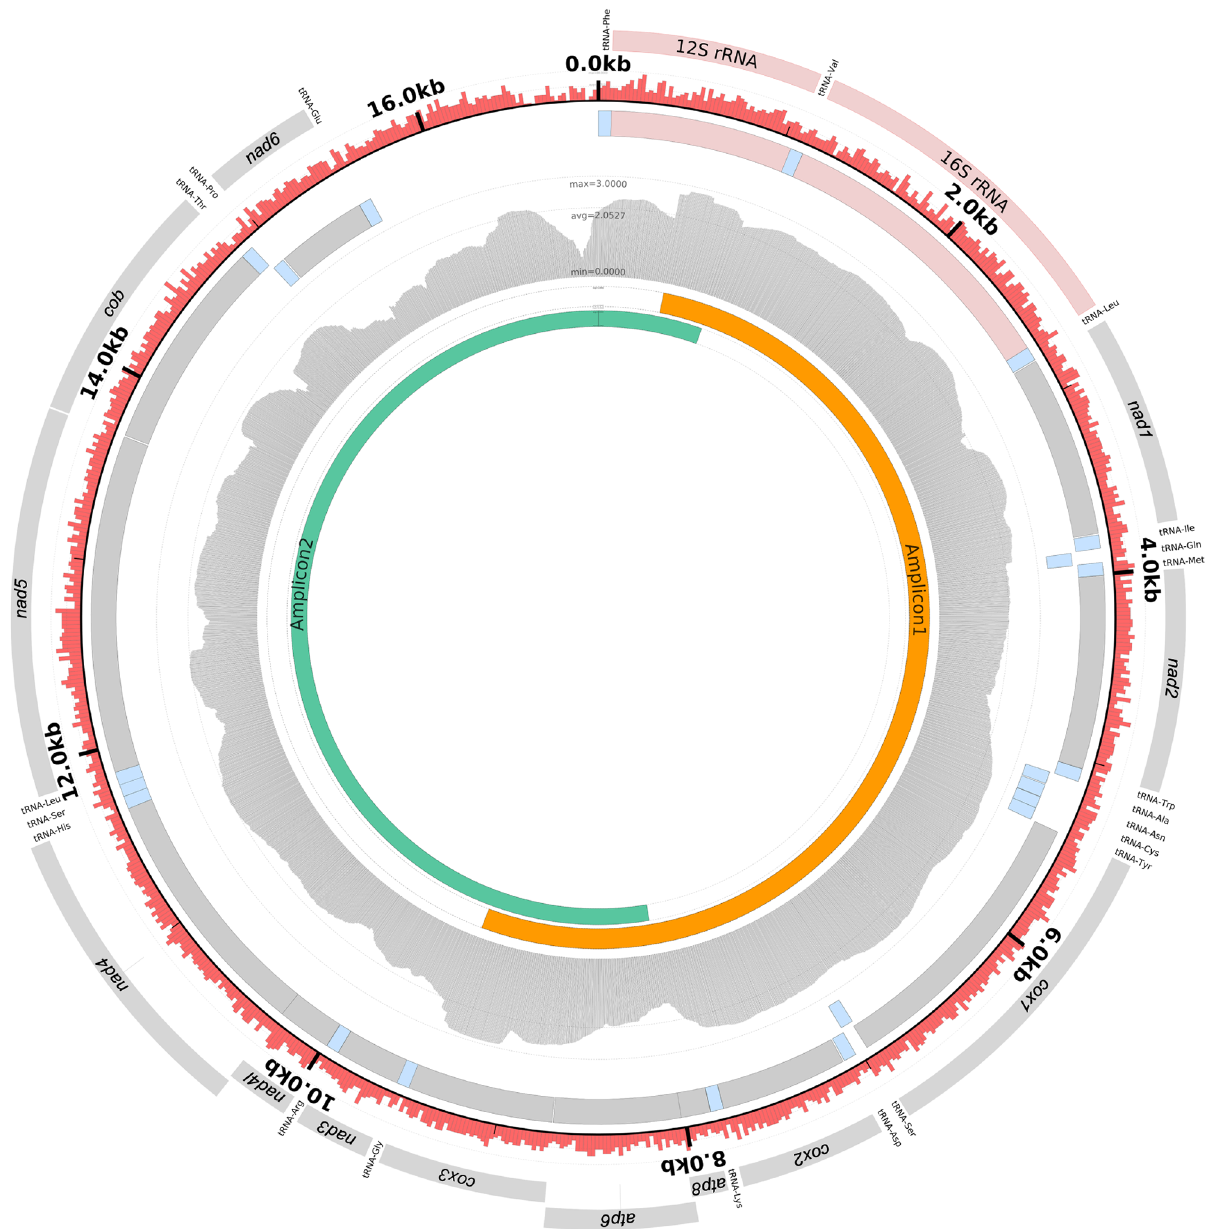
Fig 2. Graphical overview of the Corvus corax mitogenome. The figure containsthe followinginformation, from the outermost to the innermostlayer: (1) Gene products for annotated genes. (2) Genomeposition, minor ticks for every kb. Red bars illustrate GC-content in 20 bp windows. (3) Forward and (4) reverse genes. Blue coloursshow tRNAs, red colours show rRNAs and grey colours illustrate protein coding genes. (5) Coverageplot with log transformed coverage. (6) Position for amplicon1 and (7) position for amplicon2. The figure was created from GenBank accessionKX245135in the software Circleator